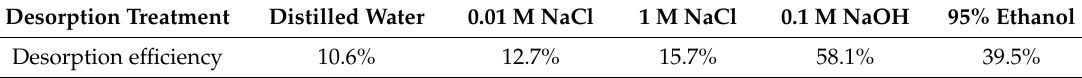
Table 6. Percentage of adsorbed CAP mass desorbed by various treatments.